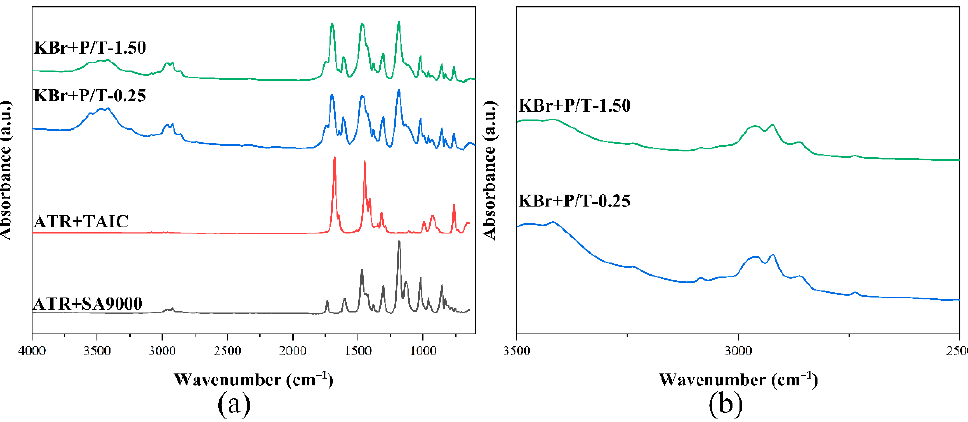
Figure 3. ( a ) The FTIR spectra of SA9000, TAIC, cured P/T-0.25, and P/T-1.50; ( b ) locally enlarged FTIR spectra of cured P/T-0.25 and P/T-1.50.